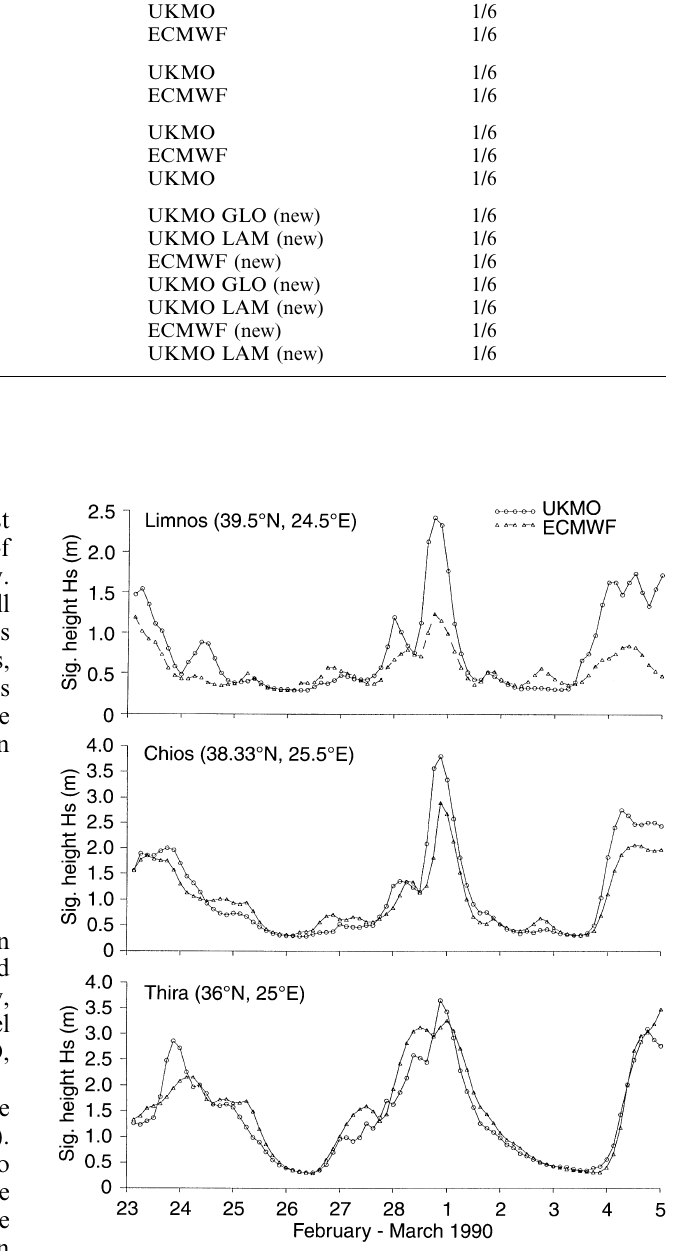
Fig. 4. Wave heights at specific grid points, February 1990 (UKMO v.